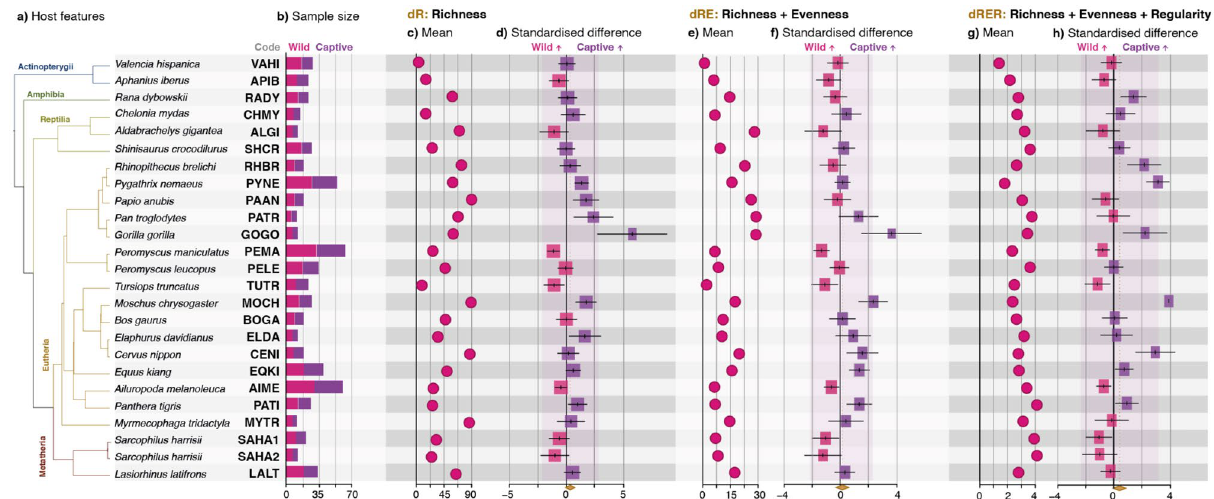
Figure 1. Diversity differences of the gut microbiota between wild and captive vertebrate populations. ( a ) Phylogenetic tree, scientific names and dataset code of the analysed host species. ( b ) Number of wild and captive individuals. ( c ) Mean richness (number of genera) detected. ( d ) Mean standardised difference between the richness (dR) of wild and captive populations. Positive numbers indicate that the captive population is richer than the wild population and vice versa. ( e ) Mean effective number of taxa detected considering richness and eveness components (dRE). ( f ) Mean standardised difference between diversity dRE of wild and captive populations. ( g ) Mean effective number of lineages detected considering richness, eveness and regularity components (dRER). ( h ) Mean standardised difference between phylogenetic diversity dRER of wild and captive